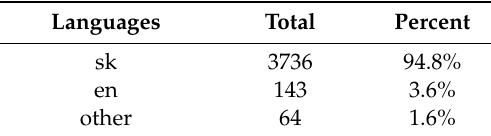
Table A48. English language availability (sk).